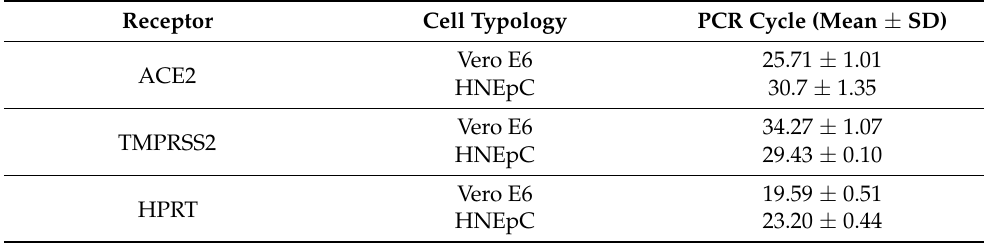
Table 2. Values obtained from 4 independent experiments conducted in triplicate and expressed as mean ± SD on both cell populations are shown. Hypoxanthine phosphoribosyltransferase 1 (HPRT) was used as an internal PCR control. Assays were conducted before each experiment to ensure that subsequent infection could occur, thus excluding cell culture-related